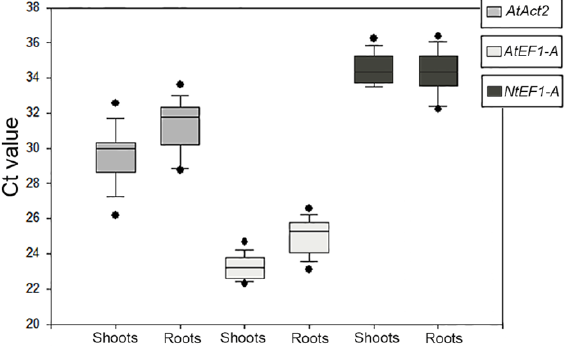
Figure 3. Quantitative real-time polymerase chain reaction of raw Ct values of the three amplification products given by the primer pairs used to identify the reference genes for Dittrichia in all experimental conditions in each sample (shoots and roots). The results are presented with box plots (middle bar, median; box limits, upper and lower quartiles; whiskers, min. and max. values).